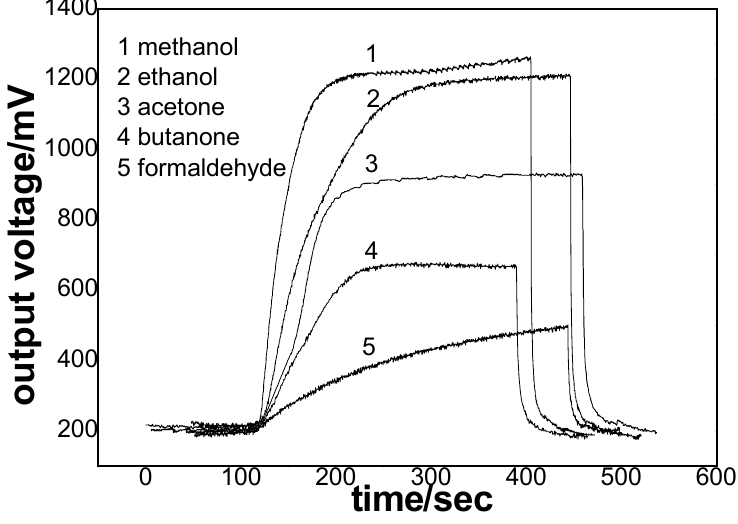
Figure 2. Static responses to butanone, acetone, ethanol, methanol and formaldehyde. Experimental conditions: applied potential 7 V, sampling dosage 0.5